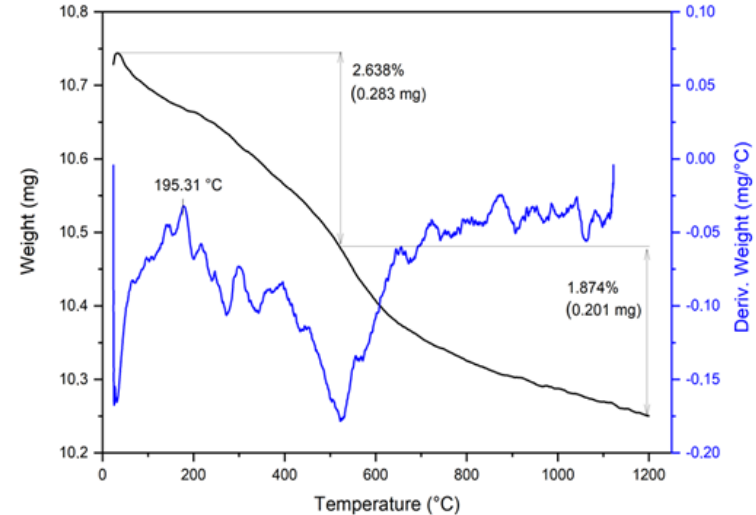
Figure 6. Result of the morisca thermogravimetric analysis.